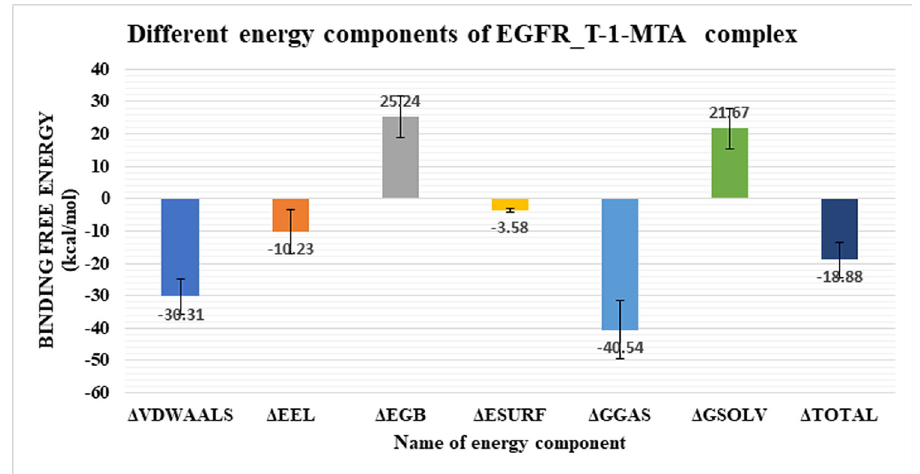
Fig 9. Energetic components of EGFR-T-1-MTA complex. Bars represent the standard deviation.